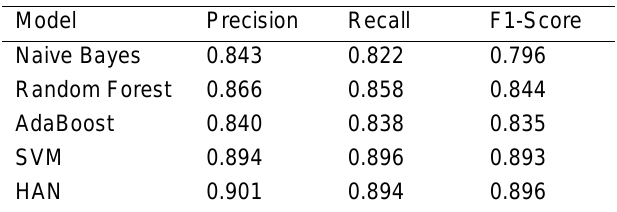
Table 3. Performance of Supervised ML models on independent test